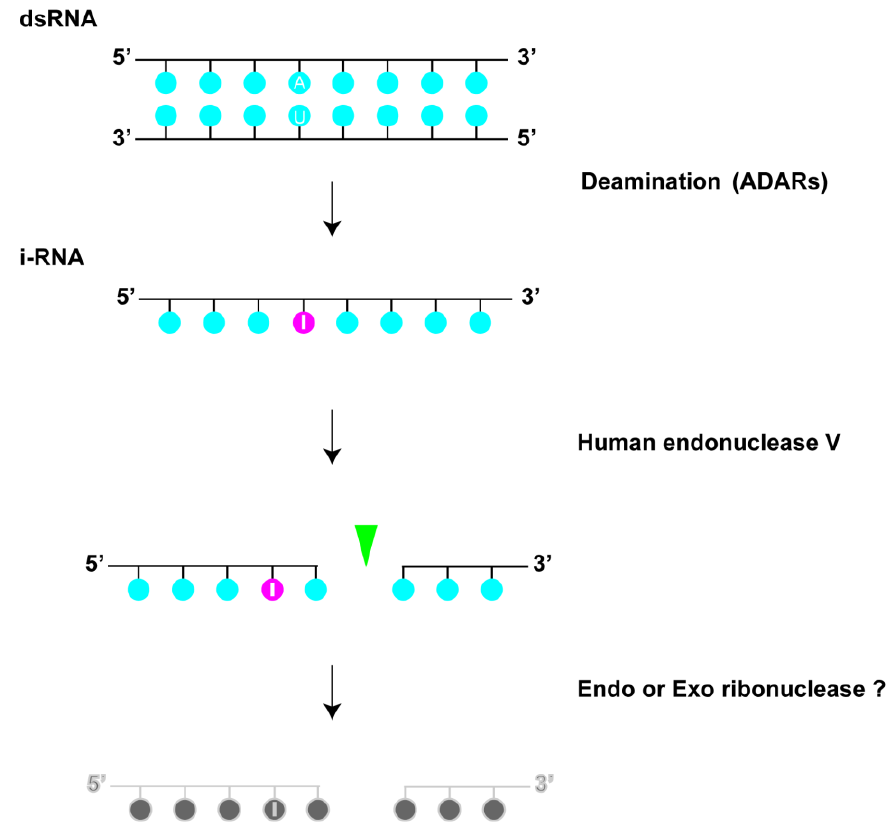
Figure 6. Human endonuclease V in RNA editing. Inosine in RNA is produced by ADARs or inosine monophosphate (IMP). Human endonuclease V can cleave the second phosphodiester bond located at 3' end of inosine in the RNA strand. Endo- or exo ribonuclease will further digest the cleaved